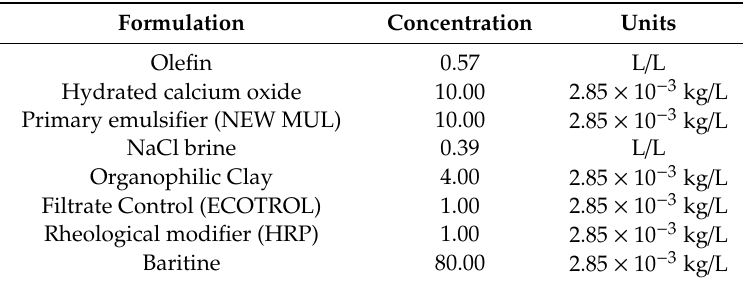
Table 1. Composition of the drilling